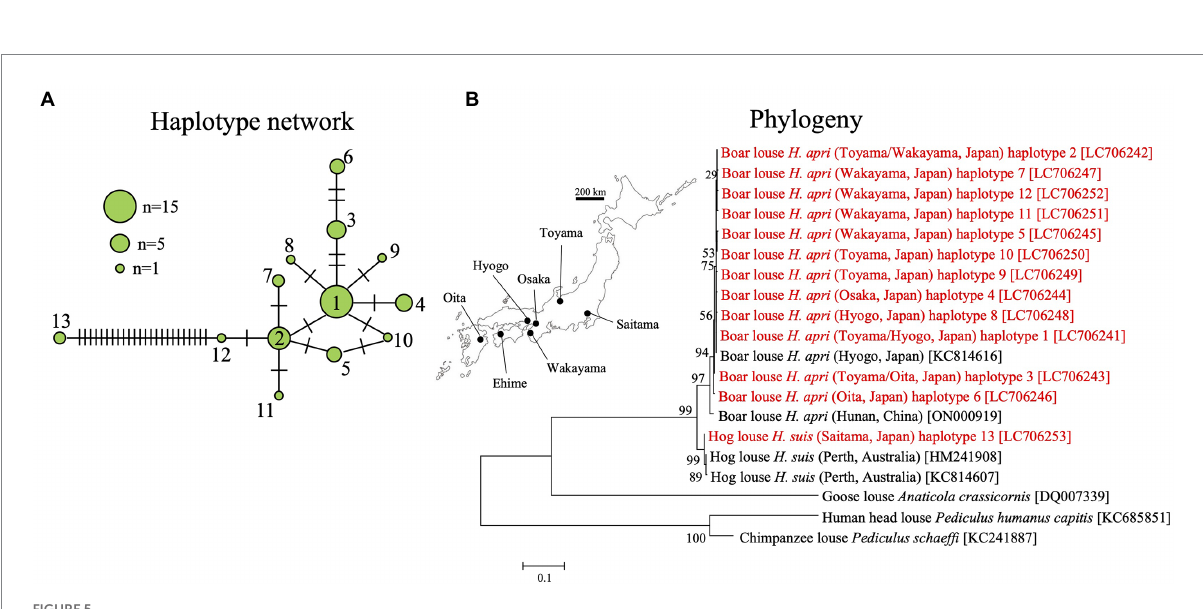
FIGURE 5 (A) Haplotype network of mitochondrial COI gene haplotypes representing 44 individuals from five collection localities of H. apri and two individuals from a collection locality of H. suis . (B) Phylogenetic relationship of the COI haplotypes of H. apri and H. suis . COI gene sequences of H. apri from Japan and China, and those of H. suis from Australia, were retrieved from the DNA databases and analyzed together. A maximum- likelihood phylogeny inferred from 516 aligned nucleotide sites is shown with bootstrap probability at each node (model: HKY + G + I). Collection locality information is shown in parentheses, whereas accession number is indicated in brackets. The collection localities are depicted on the map of Japan. The sequences determined in this study are highlighted in red.